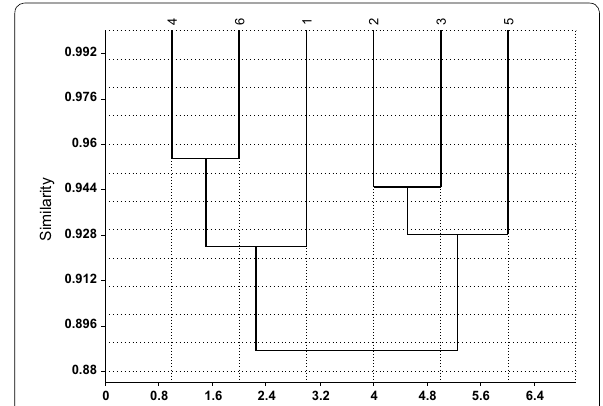
Fig. 14 Bray–Curtis Similarity index within